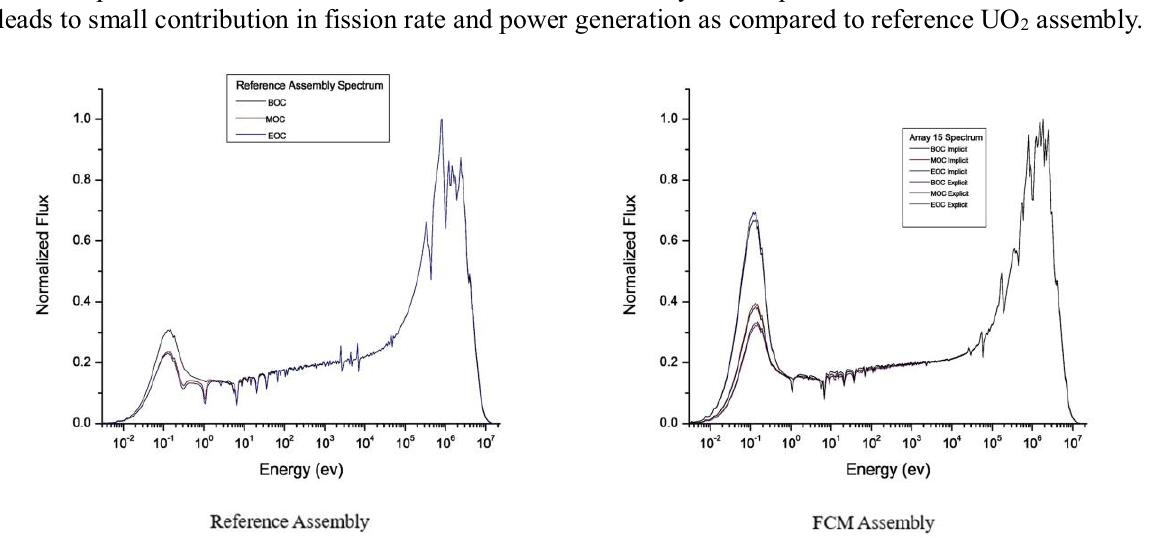
Figure 5. Spectrum Analysis of Reference and FCM